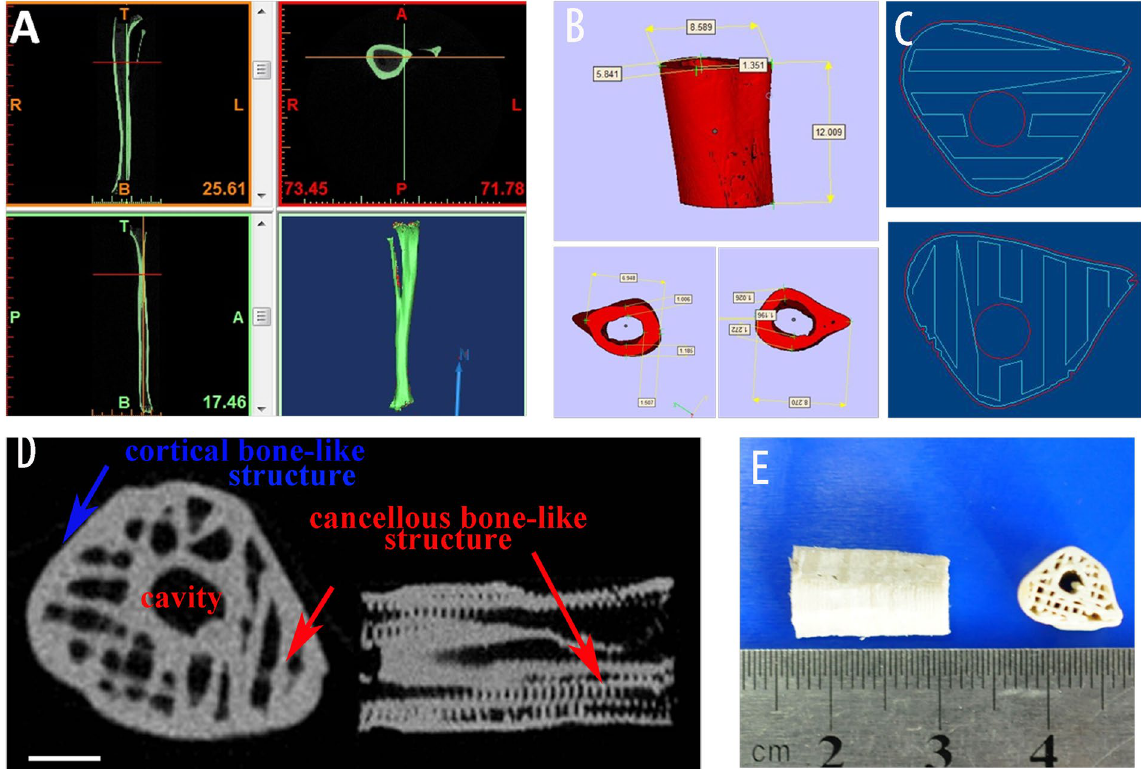
Figure 1. ( A ) CT scanning of rabbit leg, ( B ) reconstruction of 1.2 cm-long tibia structure, ( C ) the fabrication path of FDM machine, ( D ) CT scanning of prepared artificial bone scaffolds, ( E ) The photograph of artificial bone